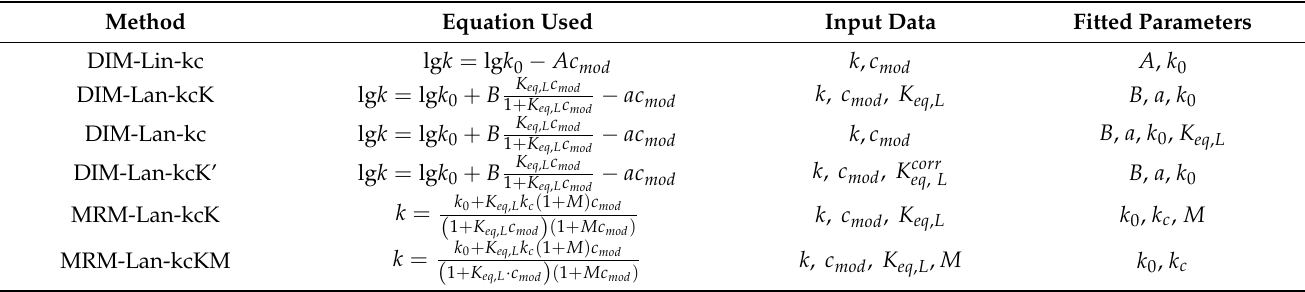
Table 2. Description of employed methods: each method is a combination of a model (DIM or MRM), adsorption isotherm, and a set of fitted